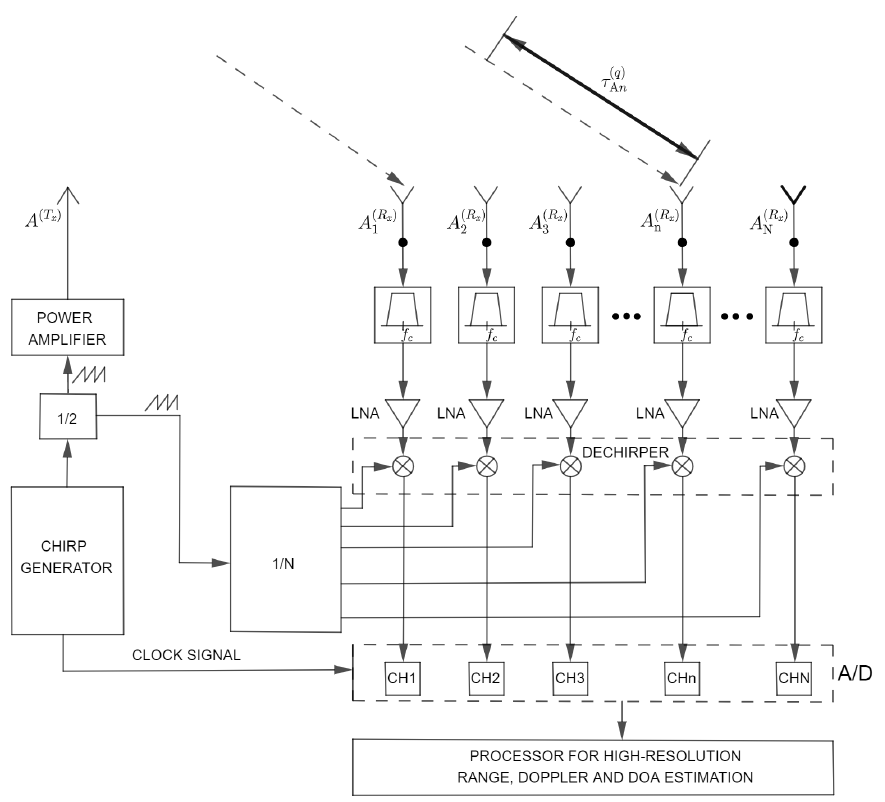
Figure 1. System